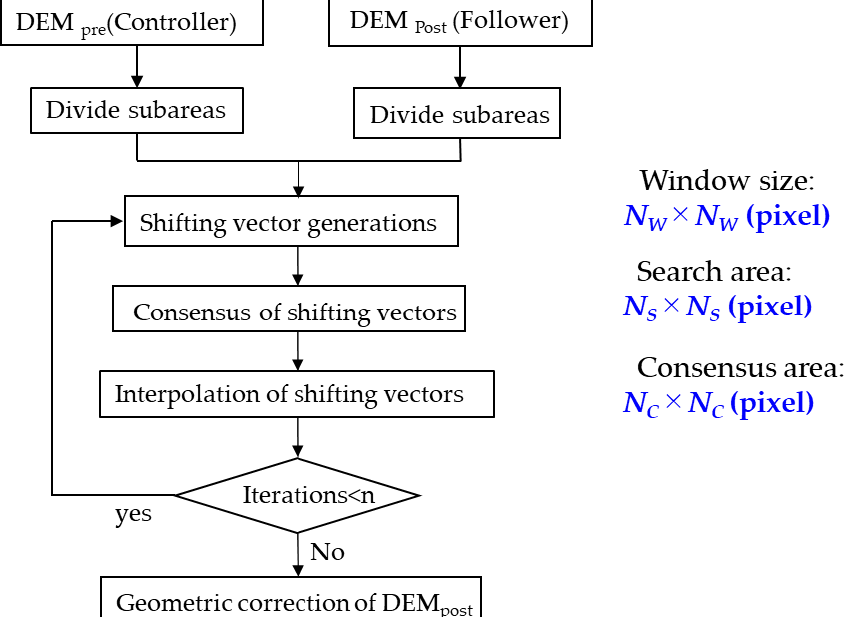
Figure 6. Flowchart of the nonlinear mapping technique.